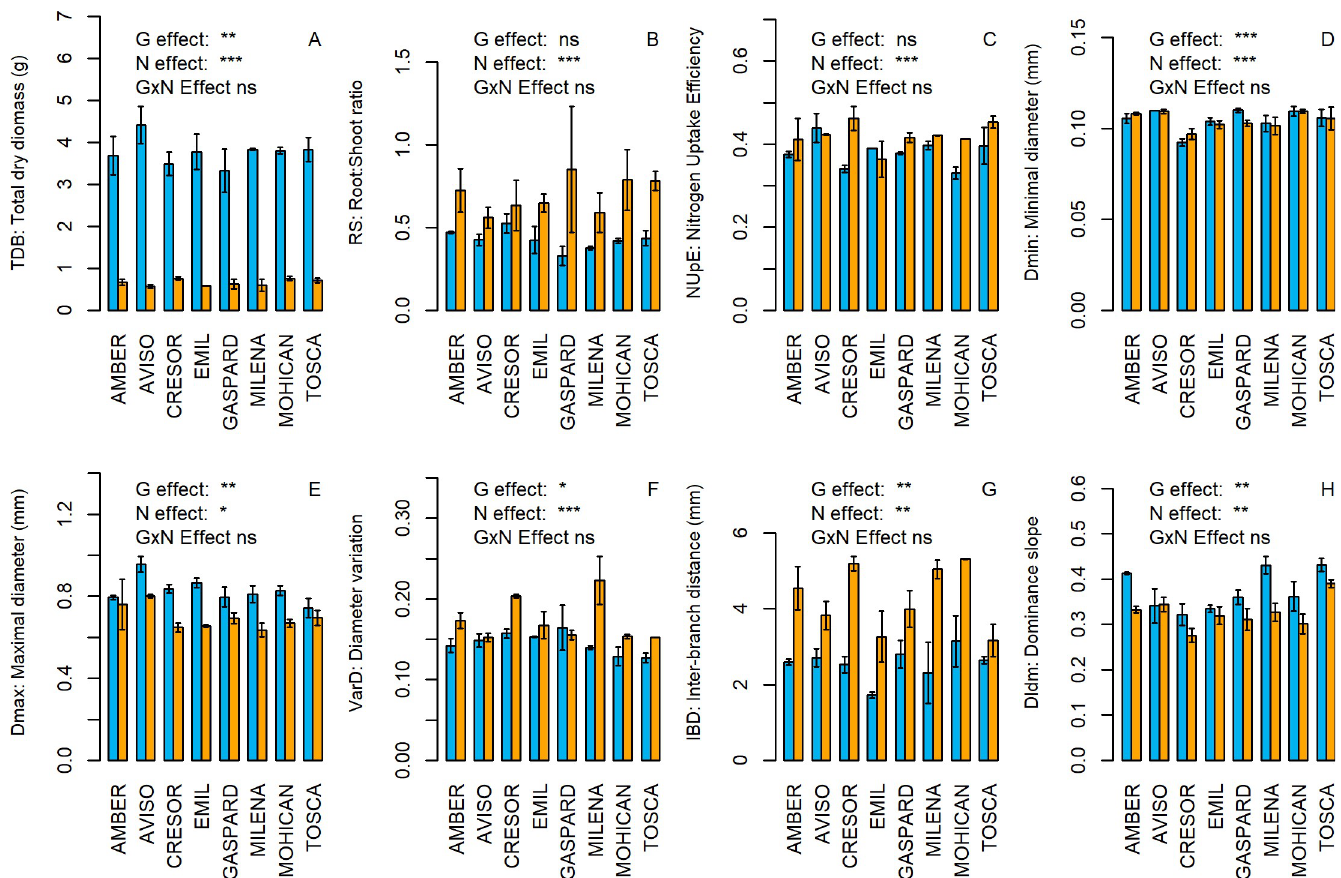
Fig 2. Genotypic variability of 5 RSA traits and 3 PA traits under N+ and N- treatments. Barplots showing mean trait values for each genotype under the two nitrogen levels on total dry biomass (A), Root:Shoot ratio (B), Nitrogen Uptake Efficiency (C), root minimal diameter (D), root maximal diameter (E), Inter-Branch distance(F), root system dominance (G) and lateral root diameter variation (H). Significant effect of genotype, nitrogen treatment and interaction between genotype and nitrogen treatment were assessed through an ANCOVA ( ��� : pvalue < 0.001; �� : pvalue < 0.01; � : pvalue < 0.05; ns: pvalue > 0.05). Orange bars stand for N- plants and blue bars stand for N+ plants (n = 2). Error bars represent standard errors (+/- SE).